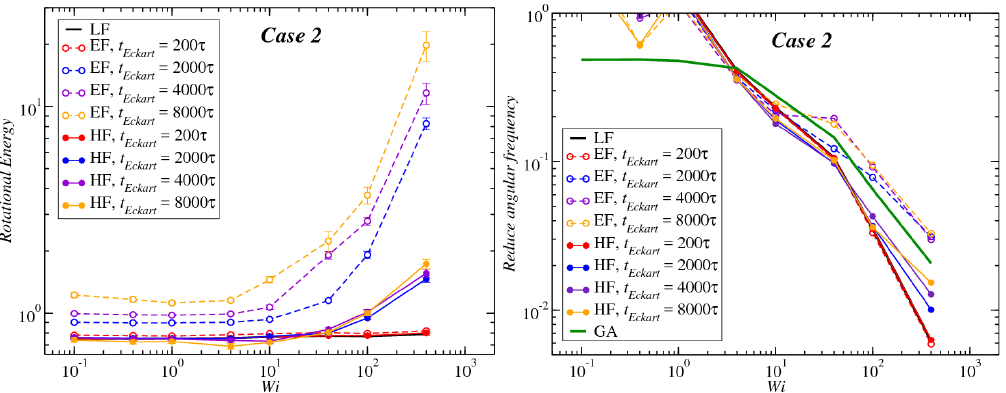
Figure 14. Same as Figure 13, but for Case 2.